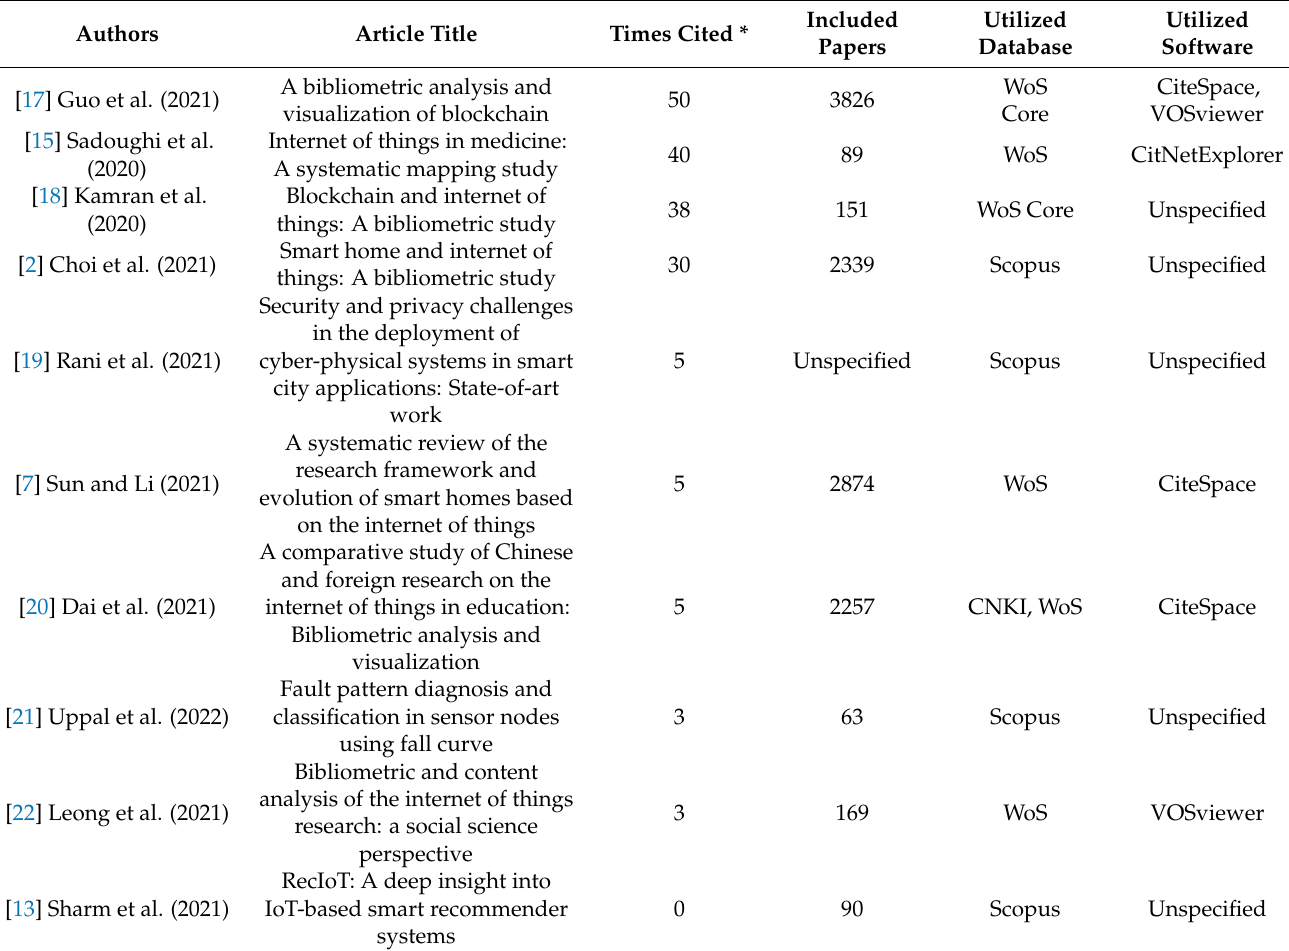
Table 1. Review of bibliometric research in the IoT based on the WoS